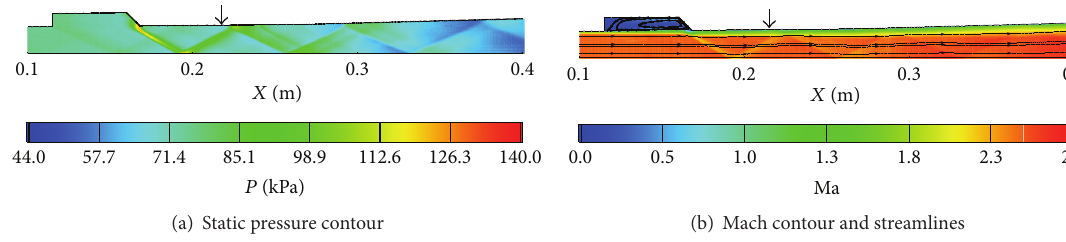
Figure 7: Detailed flow field for Case 4.